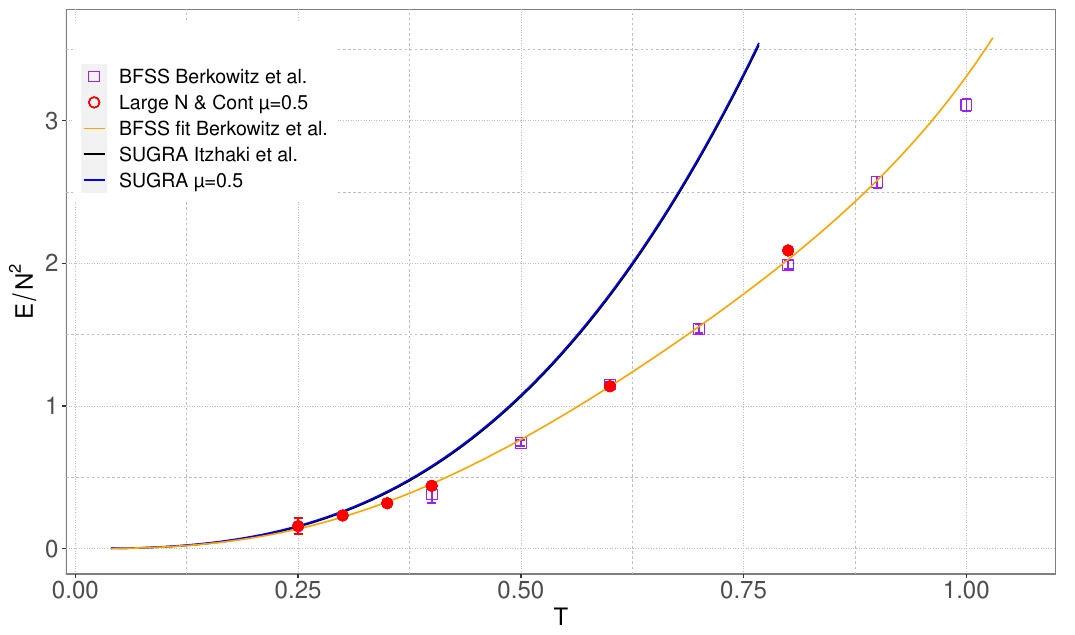
Figure 14 . We are showing all the points we have simulated so far for µ = 0 . 5 along with the BFSS points from [13]. Even though the µ = 0 . 5 points for T > 0 . 3 (see table 3) have considerable systematic errors due to the simplified extrapolations, they are consistent with the BFSS points plus finite µ corrections.